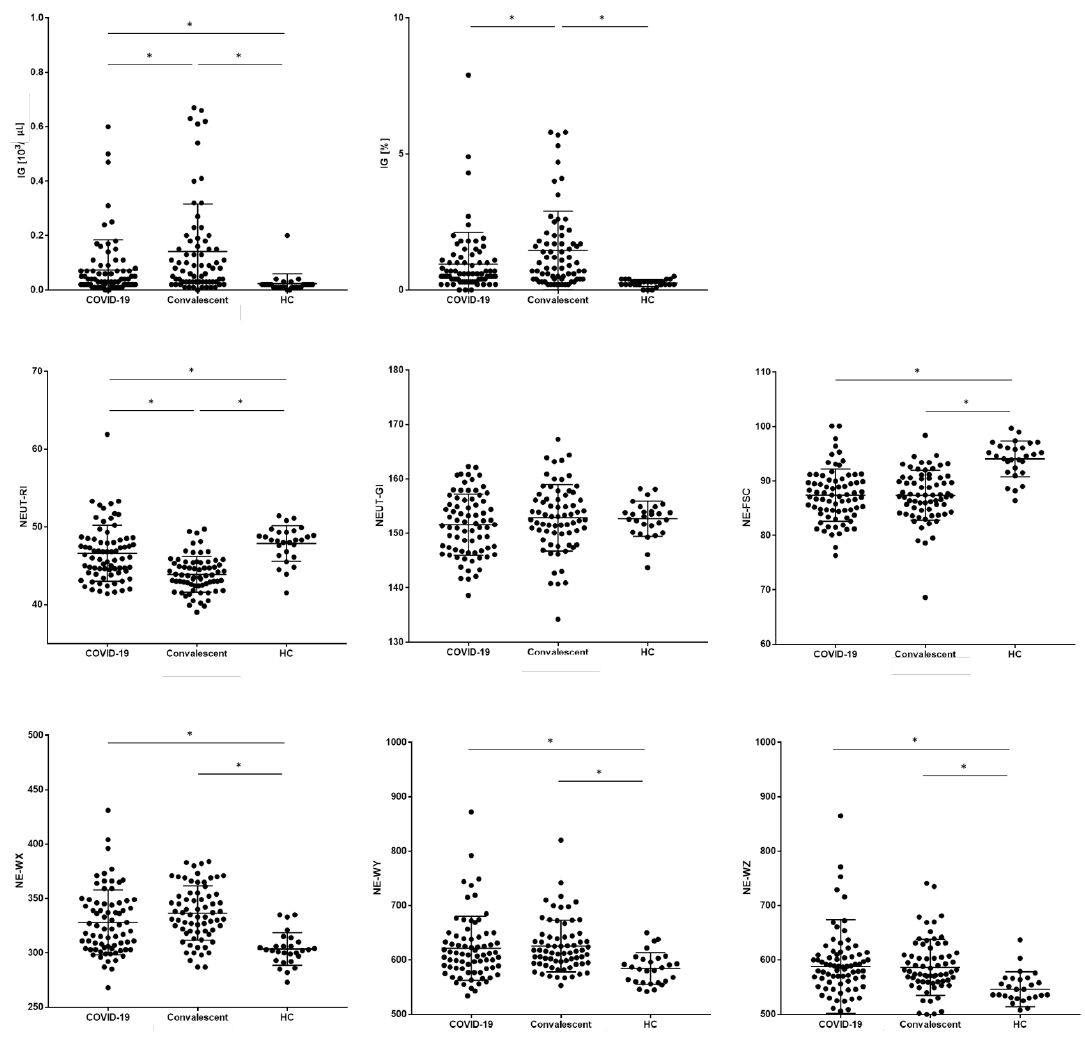
Figure 2. Differences in the proportion of new neutrophil parameters between patients with COVID-19, convalescent, and healthy control (HC) groups. Data expressed as median (Min–Max). * indicates p statistically significant.